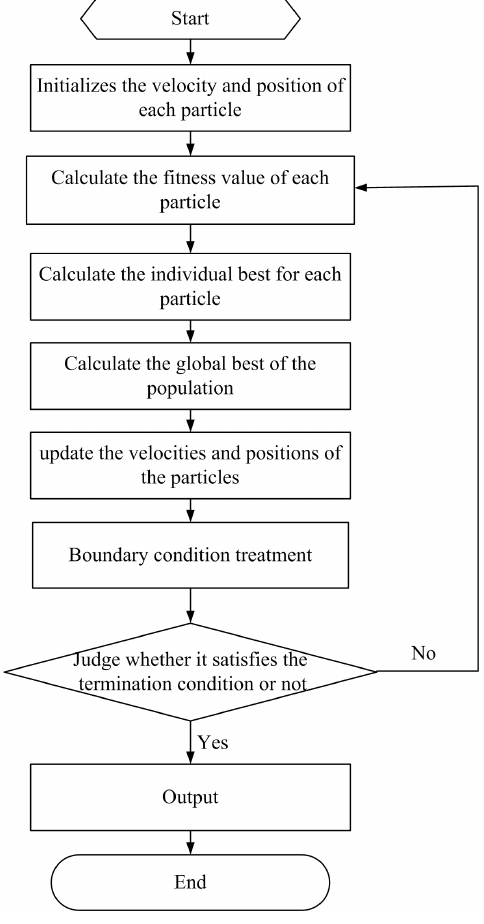
Figure 3. Operation flow of Particle Swarm